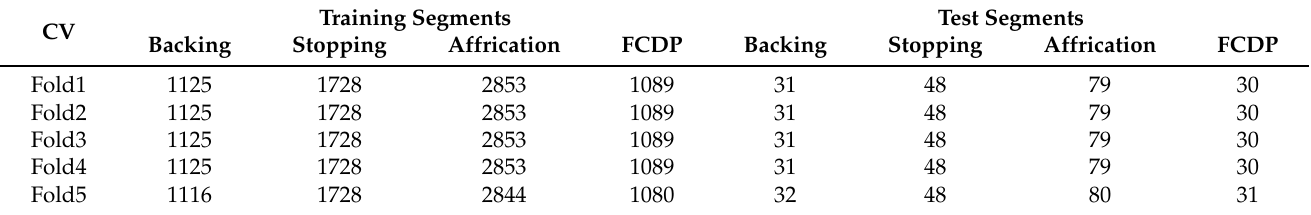
Table 6. The amount of data on single-Chinese-character